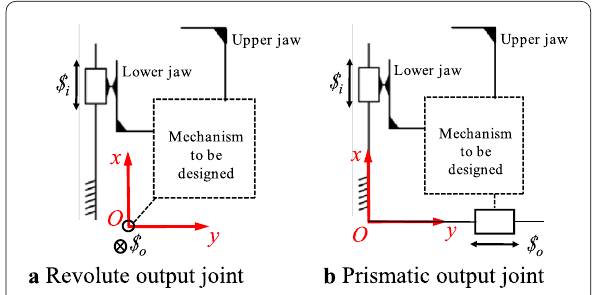
Figure 5 Schematic diagram of grasping module